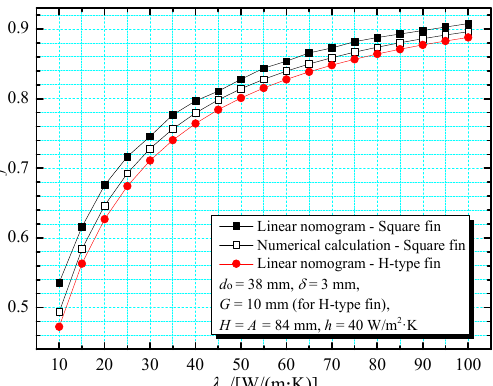
Figure 12. Influence of fin thermal conductivity on the fin efficiency of H-type and square fins.